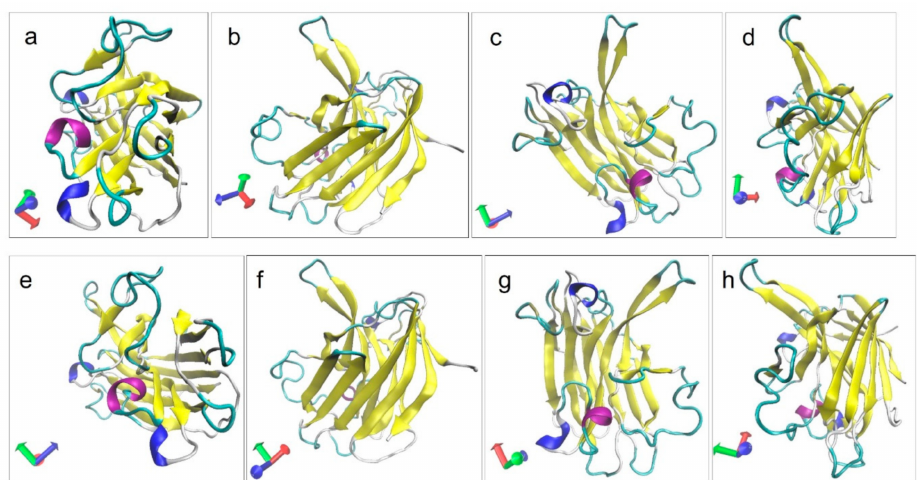
Figure A1. Predicted alginate lyase structure of A561L D4 protein based on remote homology. Protein ribbon model colors are based on a secondary structure. Top row ( a – d ): views of A561LD4 3D protein model from different dimensions; bottom row ( e – h ): view of 3D crystal structure of the marine pl-14 alginate lyase from Aplysia kurodai from different dimensions.